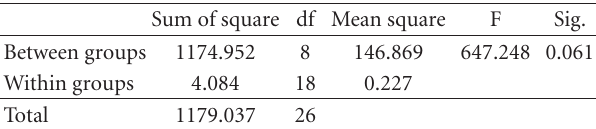
Table 2: ANOVA summary of the e ff ect of cocoon extracts concentration on fibroblast